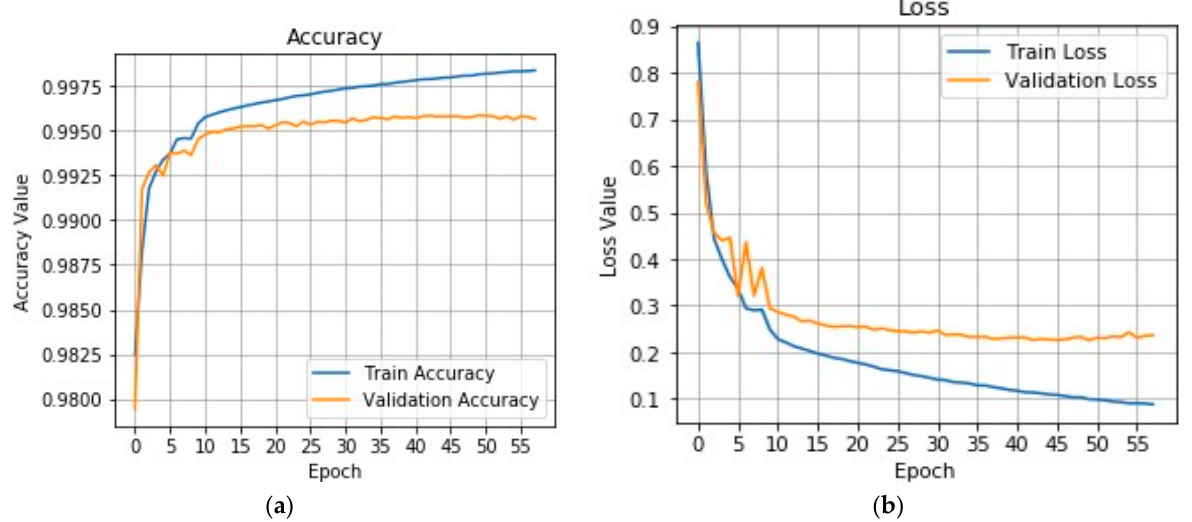
Figure 3. The graph ( a ) represents the results of the accuracy validation value on the Tianjin Universal Center of Medical Imaging and Diagnostic (TUCMD) database obtained by differential deep ‐ CNN model; and the graph ( b ) represents the results of the loss validation value on the TUCMD database achieved by differential deep ‐ CNN model.